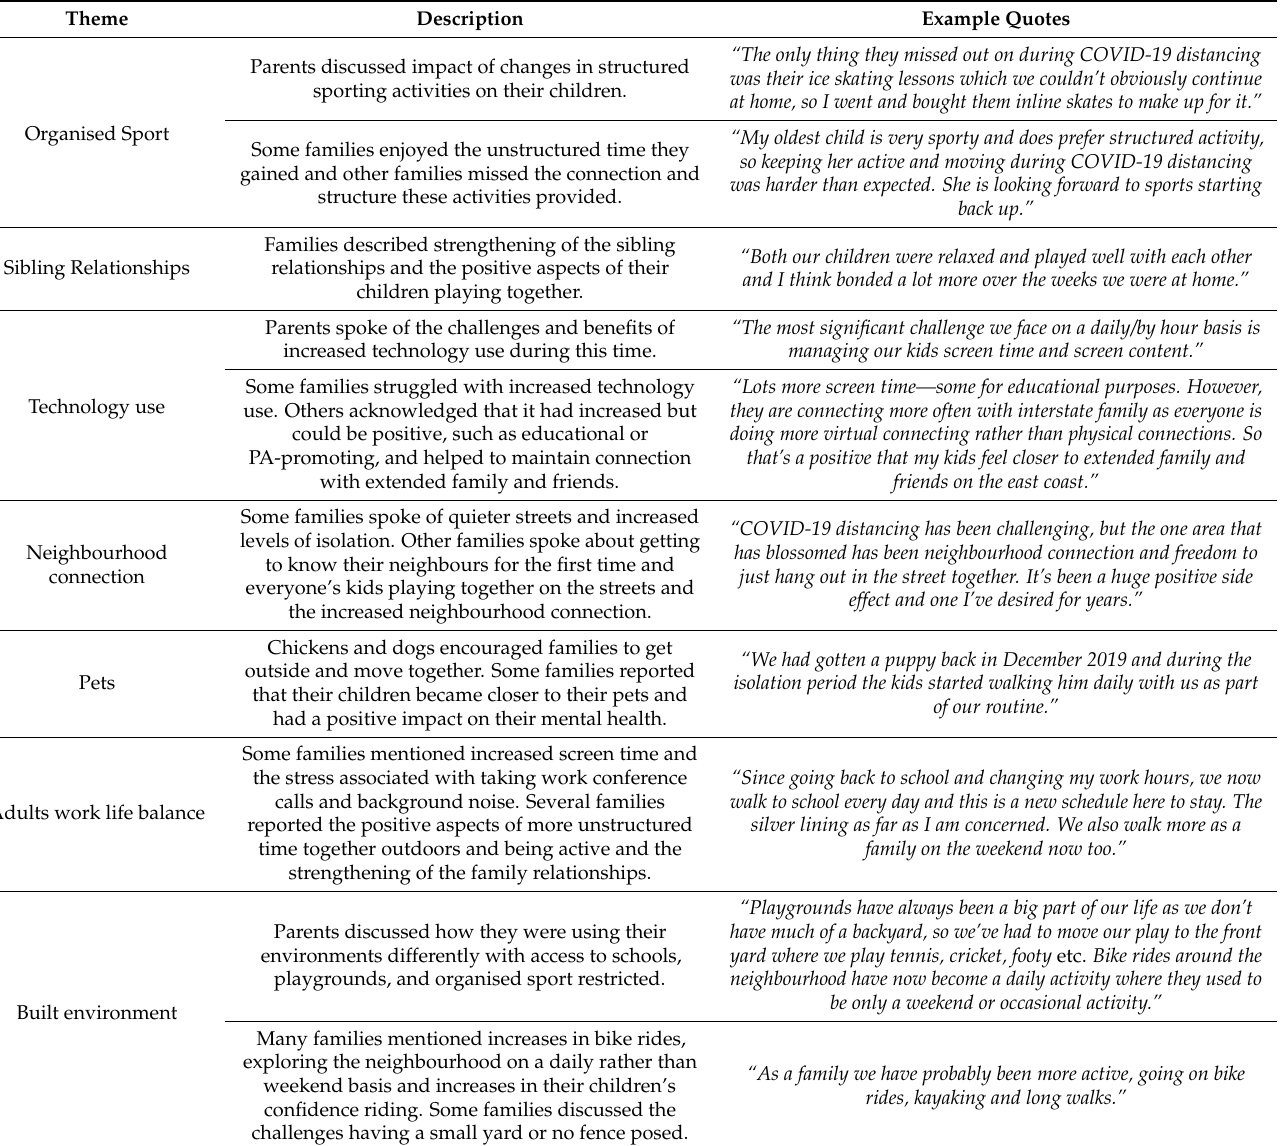
Table 3. Summary of key themes identified from open-ended responses on children’s physical activity (PA) and wellbeing before and/or during COVID-19